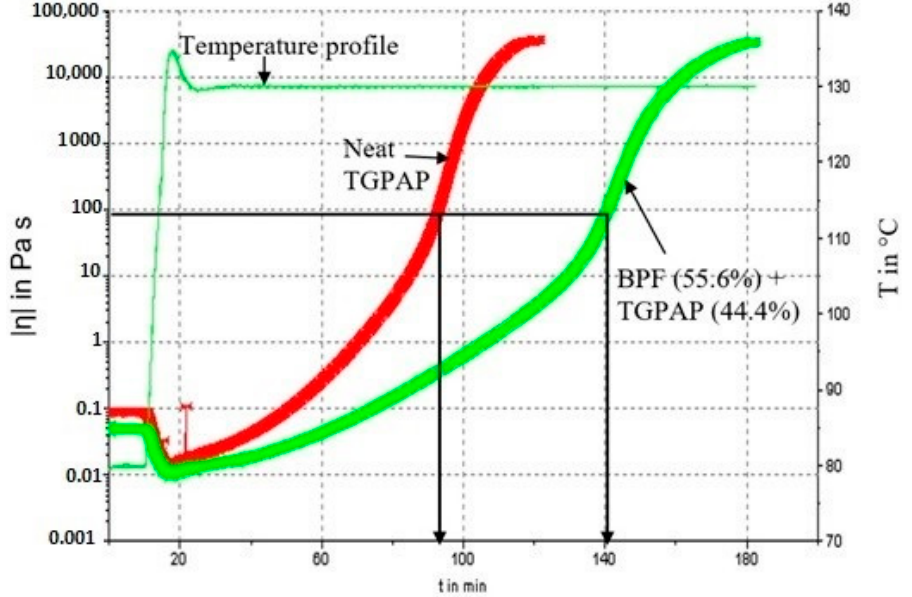
Figure 12. Representative isothermal complex viscosity profile for measuring the PW for curing of neat TGPAP (PW ≈ 97 min) and a 55.6 wt.% BPF in epoxy blend (PW ≈ 140 min).